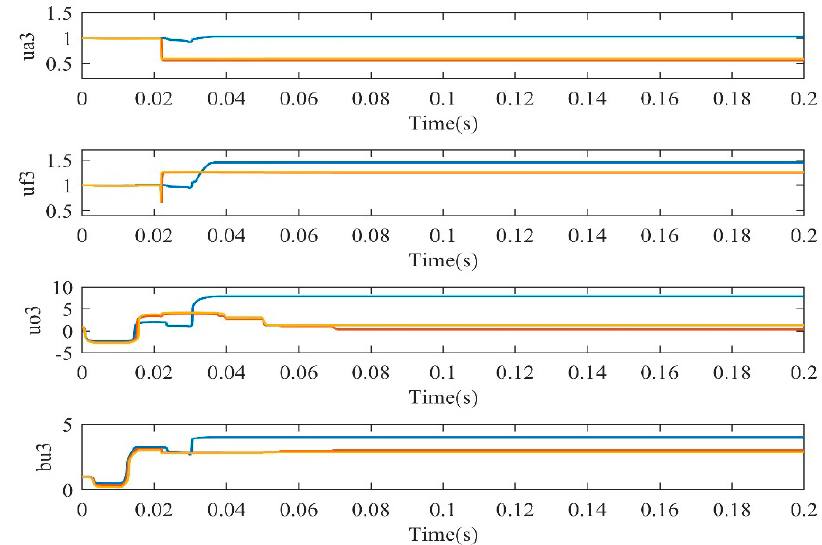
Figure 11. The third group of weights of adaptive learning curves.